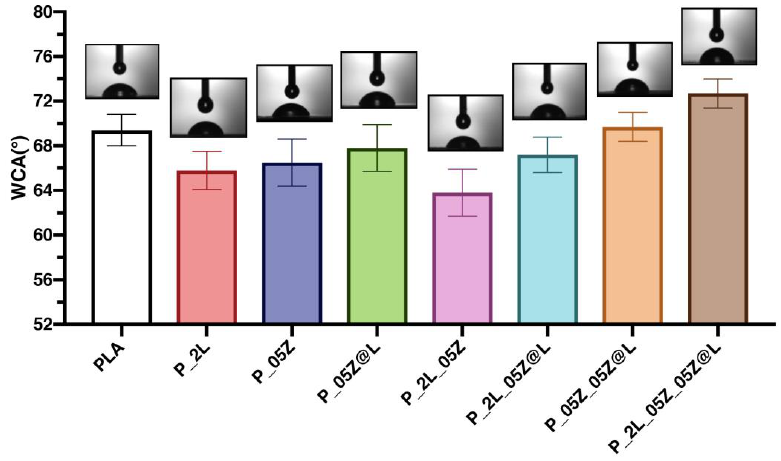
Figure 5. Water contact angles of PLA-based formulations.